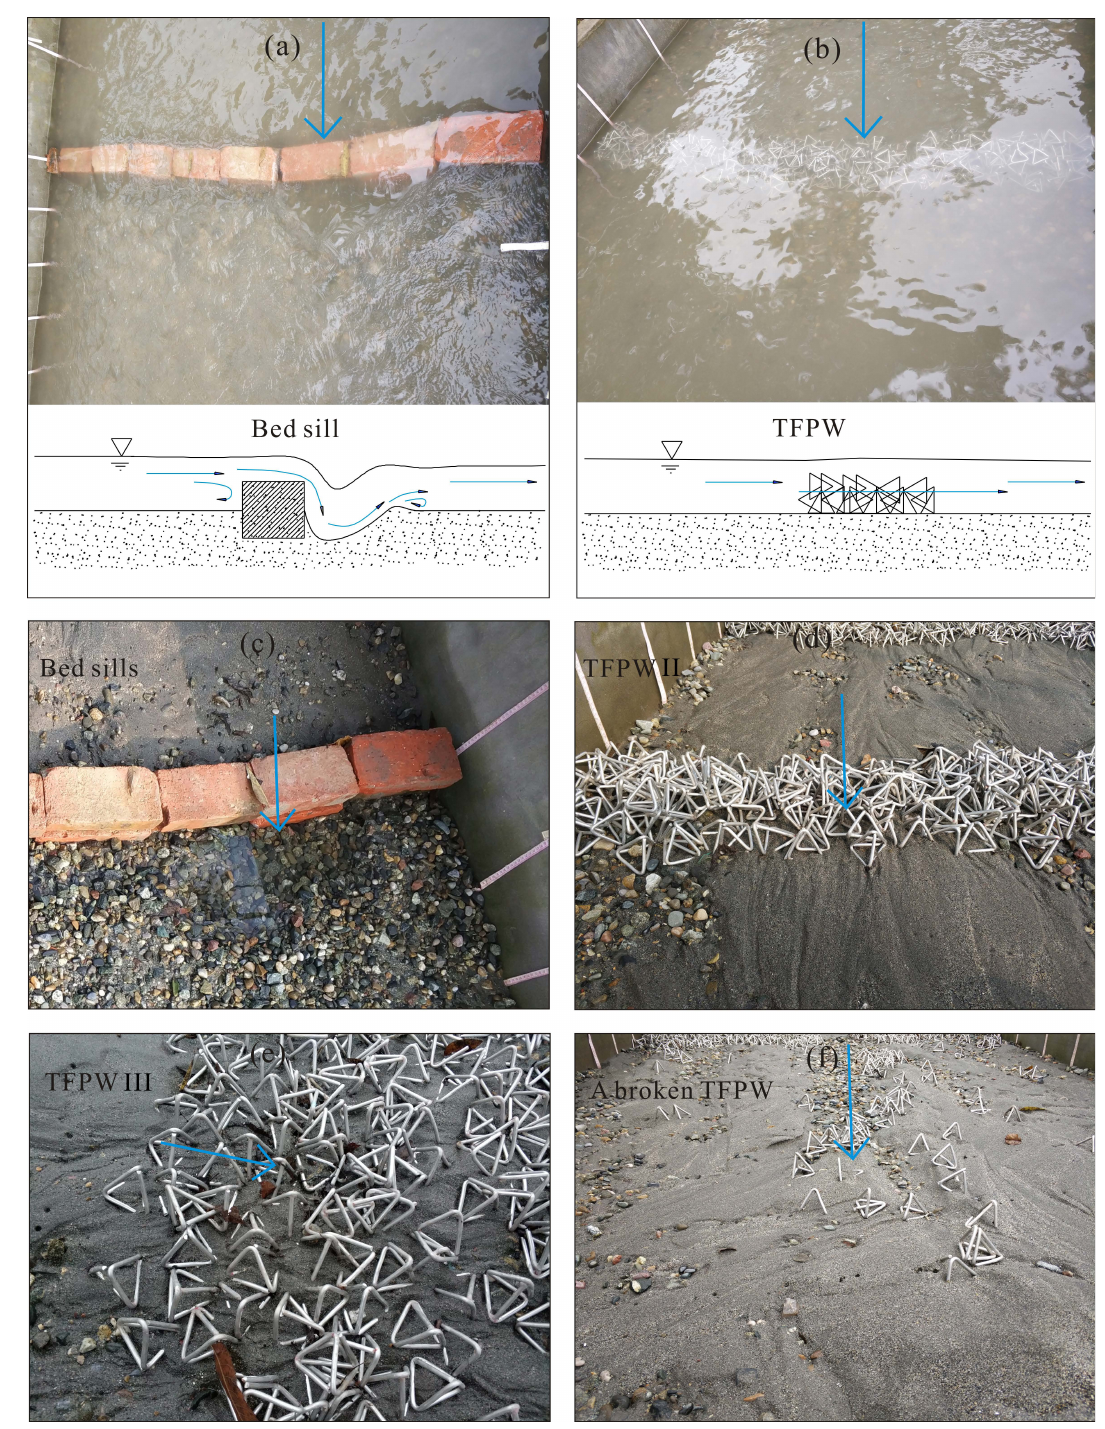
Figure 10. Flow and bedforms around solid and flexible GCSs: ( a , b ) pictures and the corresponding schematics of flow patterns during scouring when the riverbed was protected by bed sills and TFPW, respectively; ( c – e ) pictures of the structures and riverbeds after scouring when the riverbed was protected by bed sills, the random TFPW (TFPW II) and the paved TFPW (TFPW III), respectively; and ( f ) pictures of the structures and riverbeds after scouring when the riverbed was protected by another random Single TFPW, where some tetrahedron frames were washed away by a simulated catastrophic